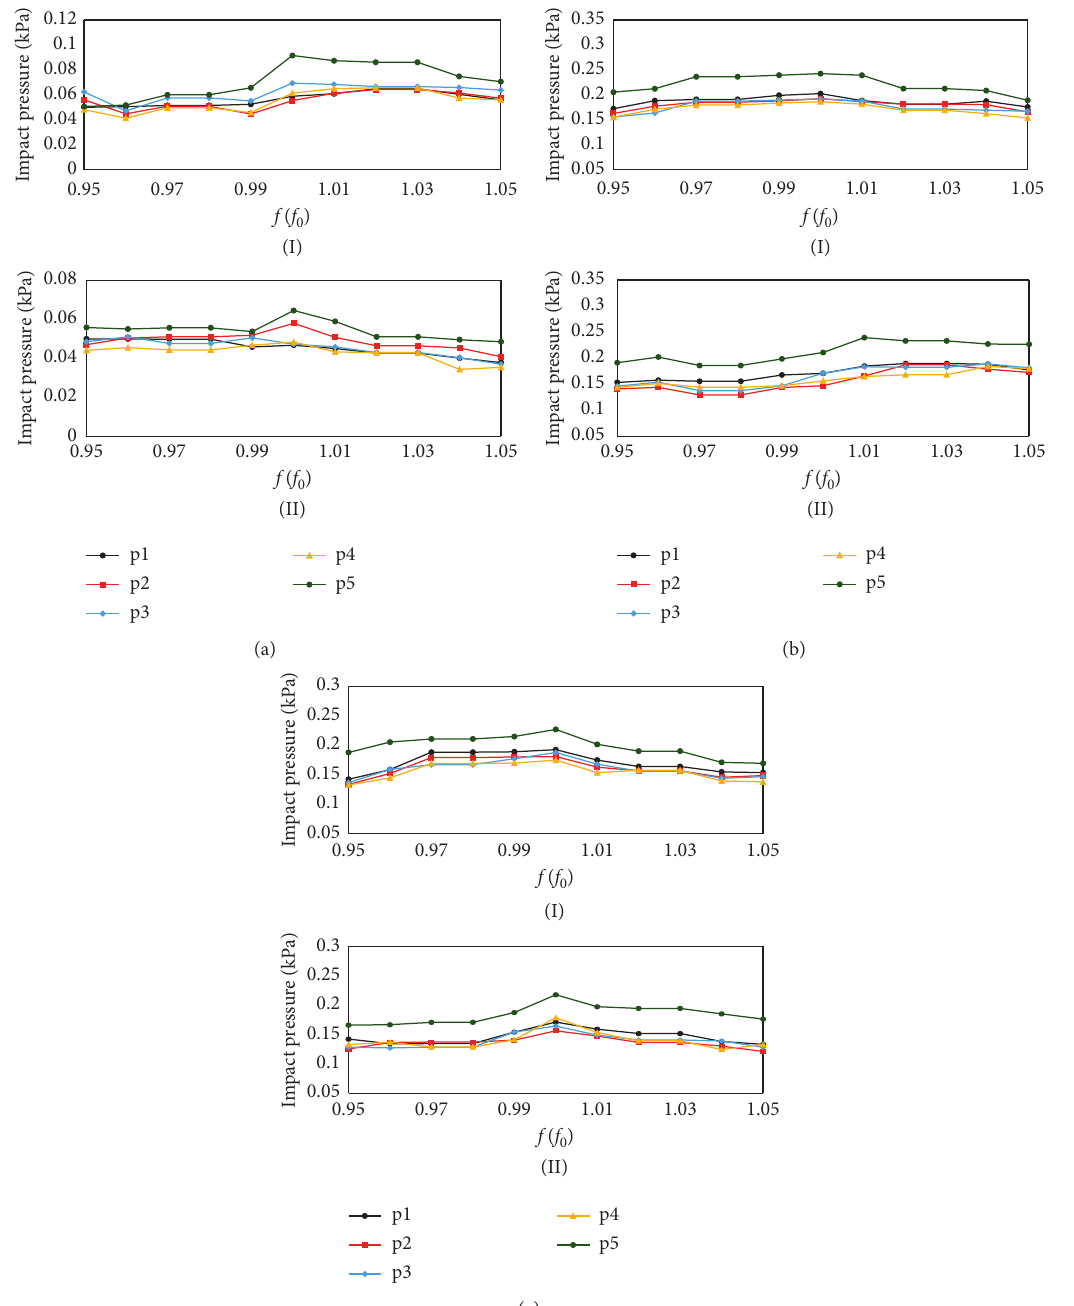
Figure 7: The impact pressure response curve to external excitation at different positions: (a) surge excitation, A � 0.002m; (b) pitch excitation, θ � 1 ° ; (c) coupled excitation of surge and pitch, A � 0.002m, θ � 1 ° , where (i) represents the impact pressure of the tank with the vertical baffle at different positions under a range of external excitation and (ii) represents that of the tank with the T-type